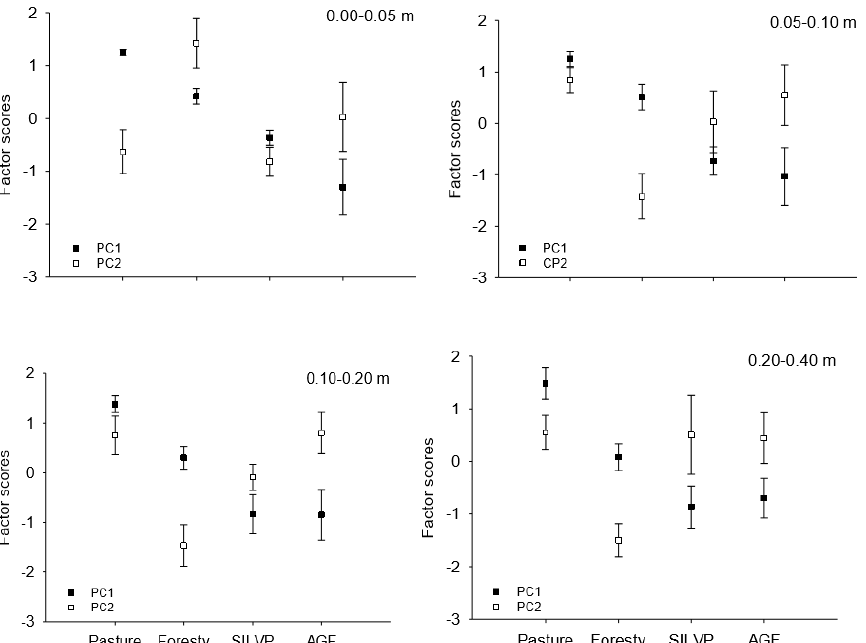
Figure 4. Graphical representation with the scores of CP1 and CP2 as a function of the treatments studied in different layers of soil depth. Vertical bars denote 0.95 confidence intervals.